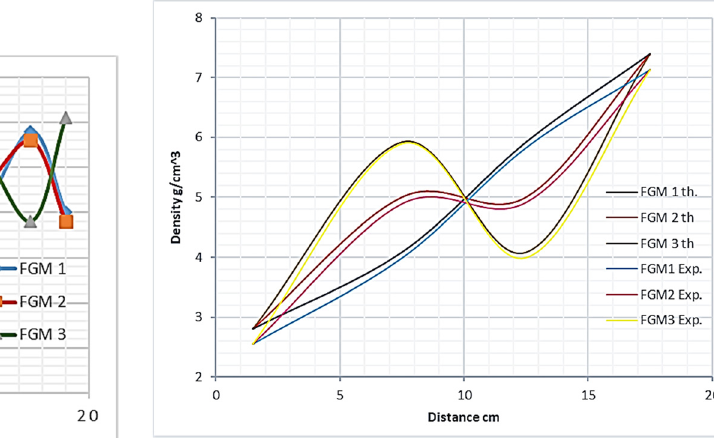
Figure 14: Circumference hardness ( outer surface ) .